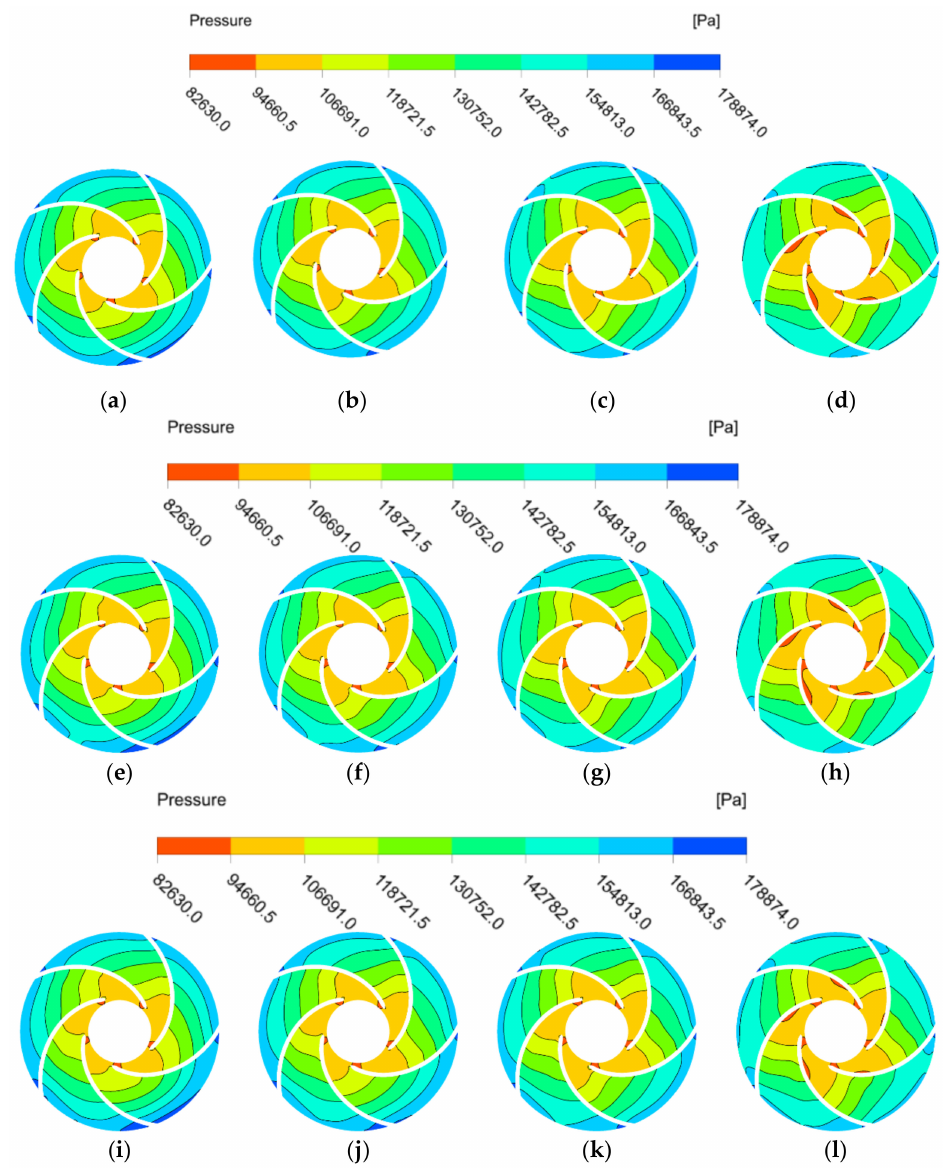
Figure 7. Pressure distribution of impeller under at different temperatures. ( a ) 0.6Q d at 25 ◦ C; ( b ) 0.8 Q d at 25 ◦ C; ( c ) 1.0 Q d at 25 ◦ C; ( d ) 1.2 Q d at 25 ◦ C; ( e ) 0.6 Q d at 50 ◦ C; ( f ) 0.8 Q d at 50 ◦ C; ( g ) 1.0 Q d at 50 ◦ C; ( h ) 1.2 Q d at 50 ◦ C; ( i ) 0.6 Q d at 70 ◦ C; ( j ) 0.8 Q d at 70 ◦ C; ( k ) 1.0 Q d at 70 ◦ C; ( l ) 1.2 Q